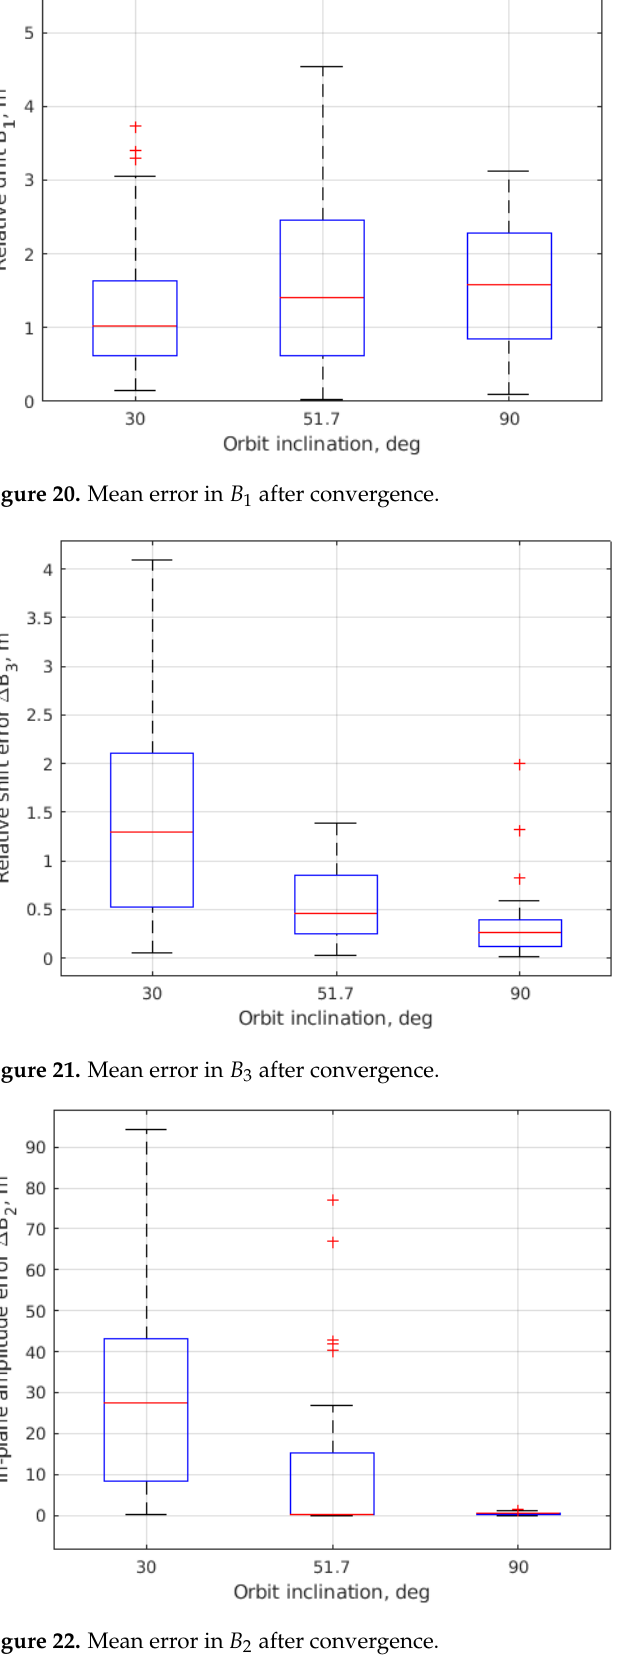
Figure 22. Mean error in B 2 after convergence.